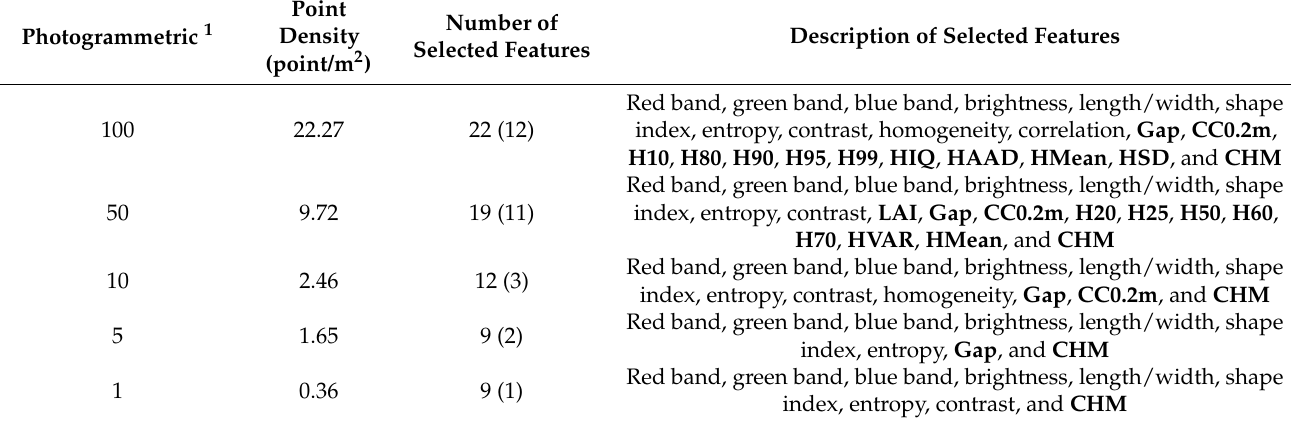
Table 7. List of selected features for the photogrammetric case with different photogrammetric point densities.